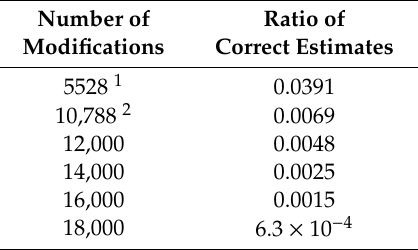
Table 1. The ratio of correct weight estimates gets smaller as the number of modifications increases.